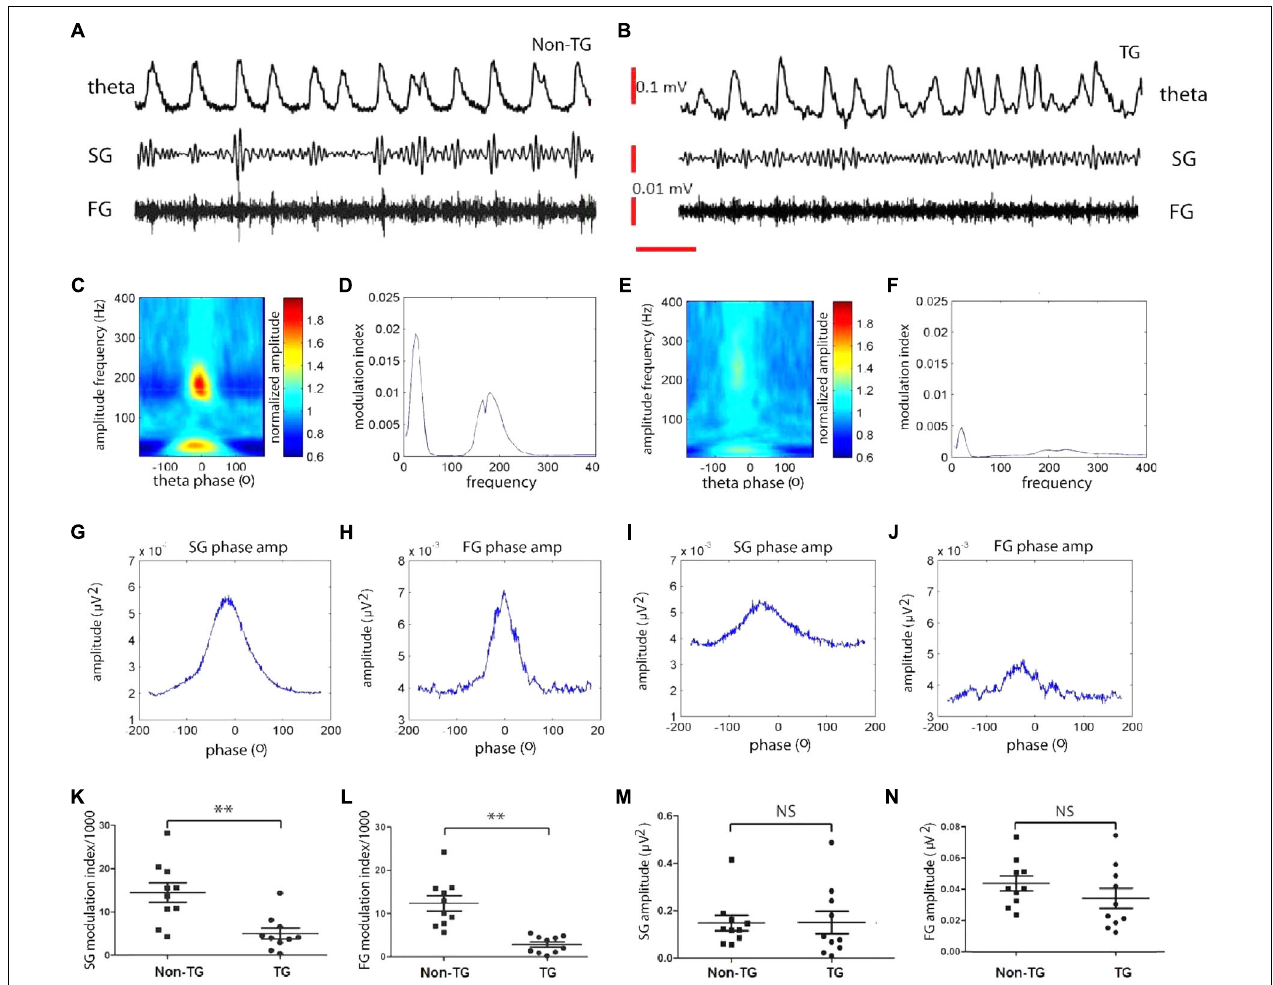
FIGURE 2 | Theta-gamma cross frequency coupling (CFC) is affected as early as 1-month in J20 model. Representative trace filtered at theta (2–12Hz), slow gamma (25–55Hz), and fast gamma (150–250Hz) frequency band recorded from non-transgenic (Non-TG) and transgenic (TG) group (A,B) . CFC between theta phase and gamma amplitude (C,E) . Red plot indicates strong coupling to theta phase (C,E) . Right plot, the modulation index (MI) value was measured to reflect how well the gamma amplitude is phase locked to the on-going theta cycles (D,F) . Gamma amplitude modulation by theta phase in Non-TG and TG, respectively, slow gamma (G,I) and high gamma (H,J) . The MI value of slow gamma and fast gamma are significantly lower in TG group than those from Non-TG group, as shown in K and L . The reduction of MI value was not due to gamma power change as shown in M and N . The TG and Non-TG group have similar slow gamma and fast gamma power (M,N) . ( n = 10 in each group, t -test, ∗∗ : p < 0.01, NS: p >